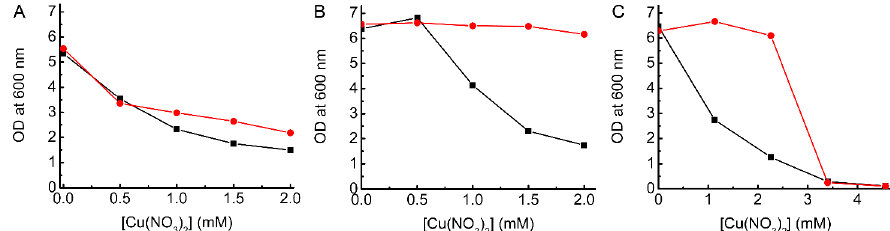
Figure 2. Complementation studies of Δ copA E. coli . Growth after 12 h (37 °C) of Δ copA E. coli plus pBAD33_ copA (red circles) and pBAD33 (black squares) in LB media in the presence ( A ) and absence ( B , C ) of 0.2% L ‐ arabinose at increasing concentrations of added Cu(NO 3 ) 2 (all single replicates and the data shown in ( C ) were acquired over a larger Cu(NO 3 ) 2 concentration range). Growth curves are shown in Figures S1–S3.